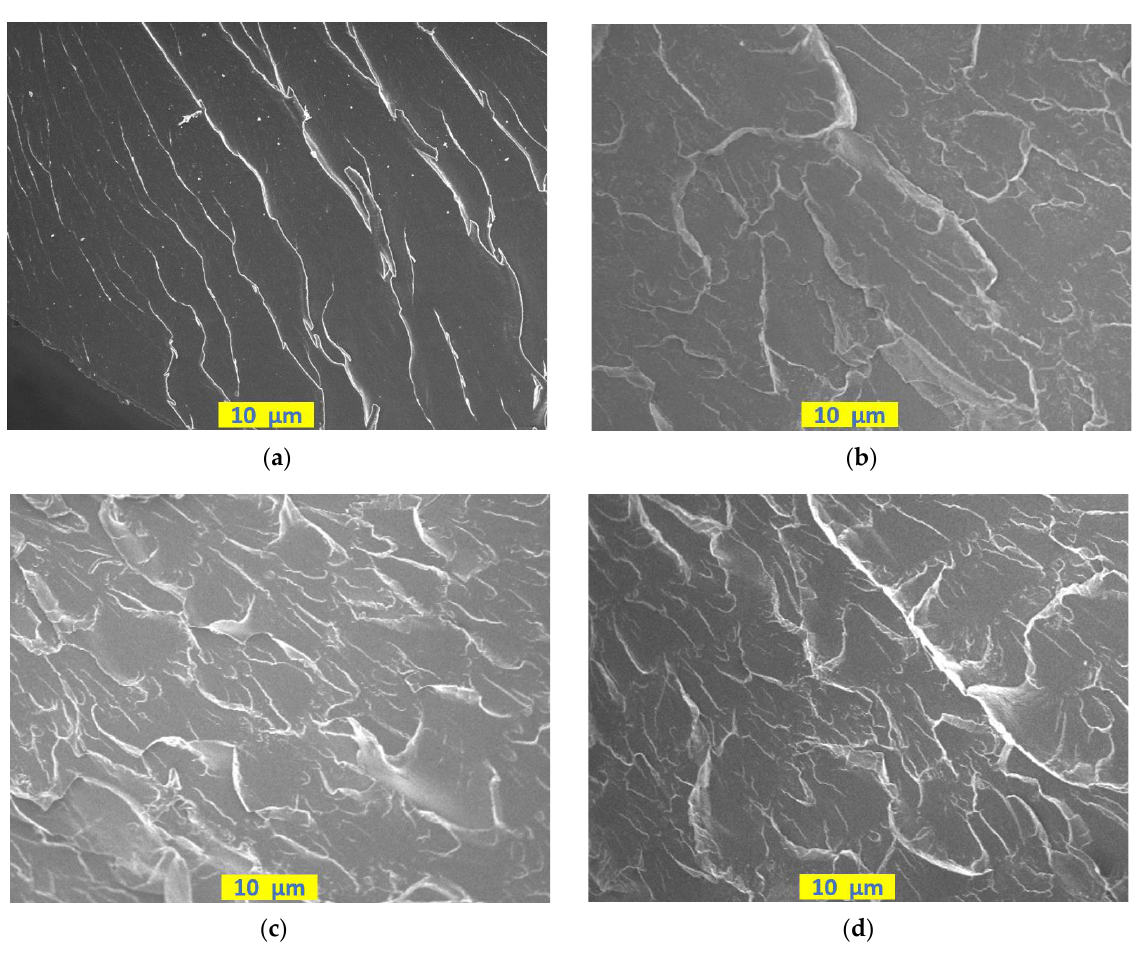
Figure 9. SEM images of fracture surface for ( a ) neat epoxy, ( b ) graphene – epoxy, ( c ) nanosilica – epoxy, and ( d ) graphene – nanosilica epoxy. and ( d ) graphene–nanosilica